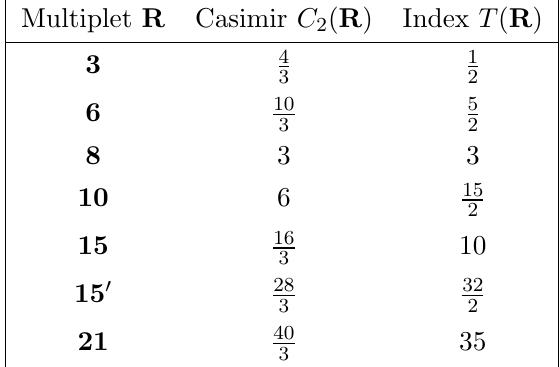
Table 1 . The quadratic Casimir and the Dynkin index for higher multiplets of